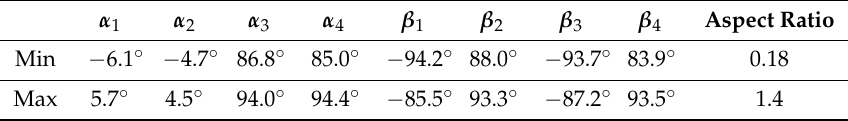
Table A3. Valid value range of the geometric